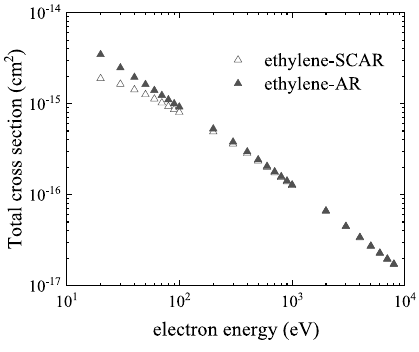
Figure 3. Total cross section of atomic Fe at di ff erent incident electron